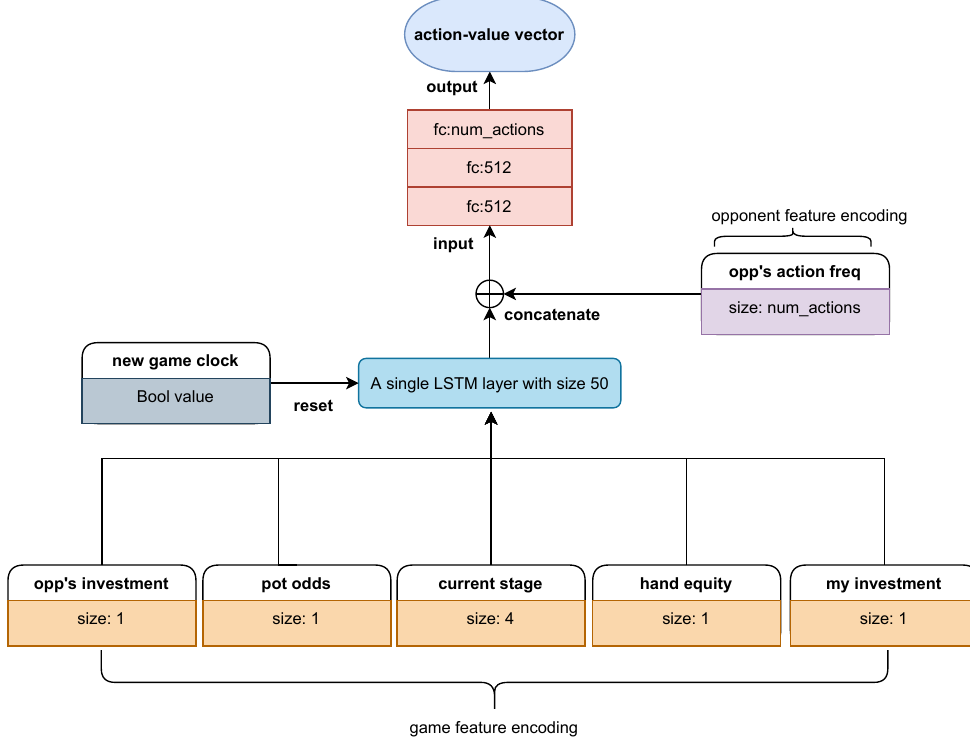
Figure 3. Arc_lstm, an improved architecture compared to Arc_pro. The biggest difference is the addition of an LSTM layer, which helps to extract useful temporal features and learning adaptive